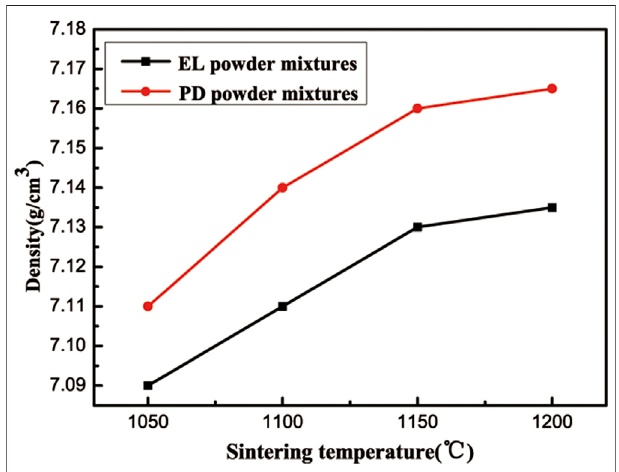
FIGURE4| DensityoftheFe-2Cu-0.8C-0.6Mo-2Wsamplessinteredfor different times.